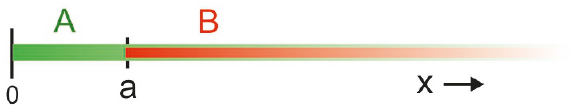
Figure 1 . Diagram of the spatial regions A and B considered. Both A and B are half spaces, chosen so that B (cid:18) A